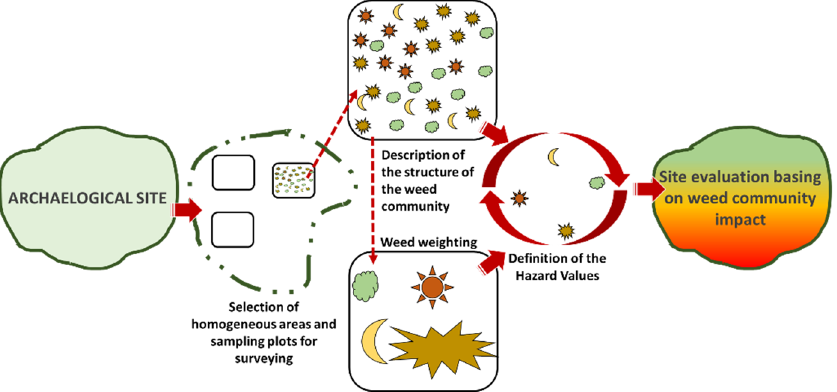
Figure 2. Schematic representation of the followed procedure. Table 2. List of the abbreviations used for the description of the procedure.